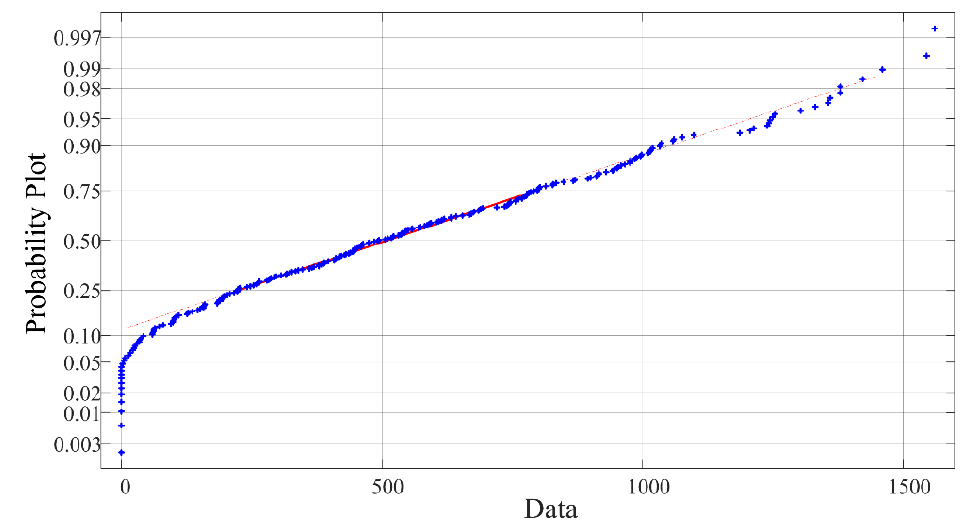
Figure 6. Probability diagram of the normal distribution of data.